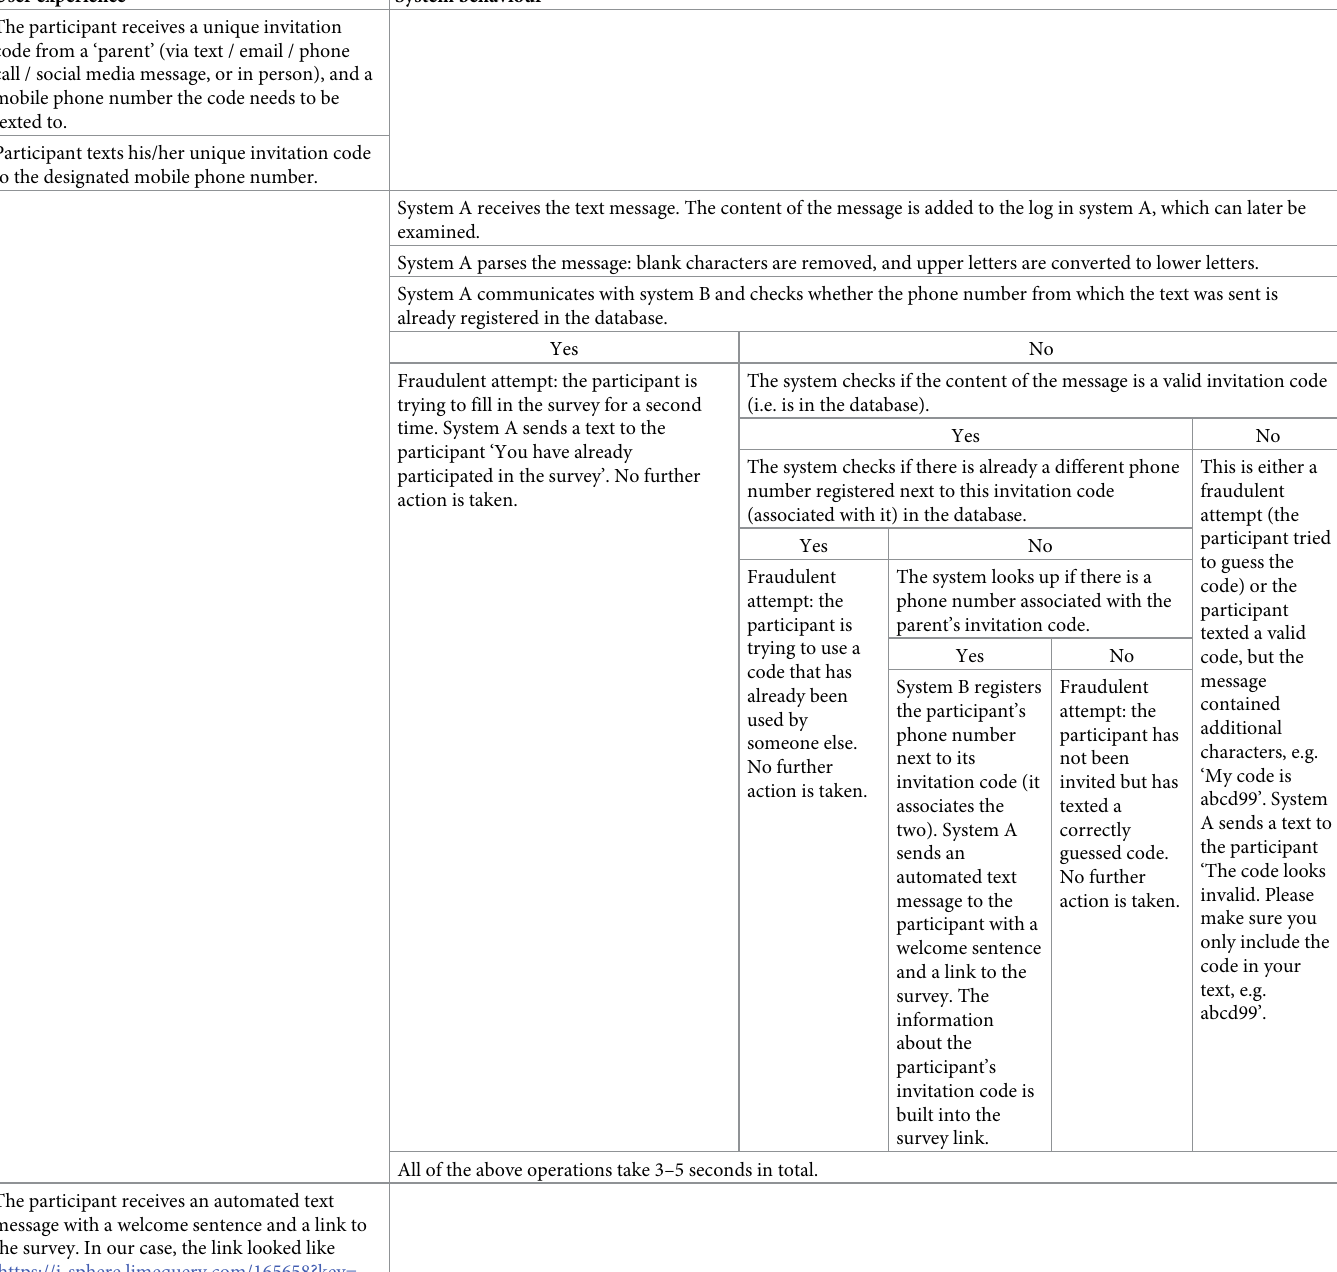
Table 1. The chronological flowchart of user experience and system behaviour during data collection